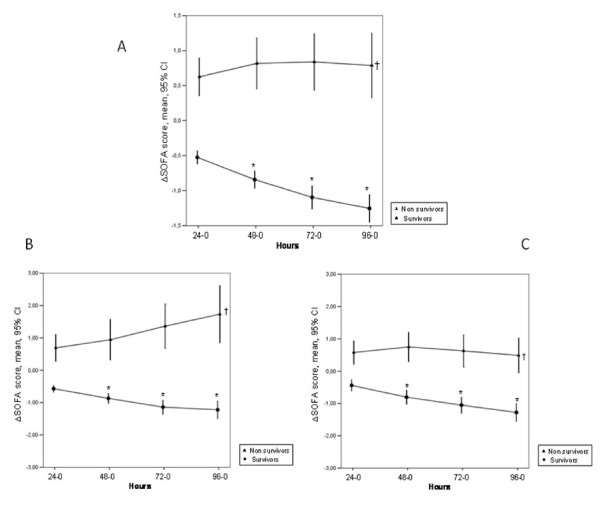
Error bars representing the delta SOFA scores (mean ± 95% CI) during the first 4 days in the ICU in survivors (solid circles) and nonsurvivors (solid triangles) in the whole cohort (A) (n = 2,933) and in patients without (n = 1,789) (B), or with sepsis (n = 1,144) (C). *P < 0.05 compared with ΔSOFA 24-0 (ANOVA with Bonferroni correction for multiple comparisons); †multifactorial ANOVA; P < 0.05 compared with survivors.